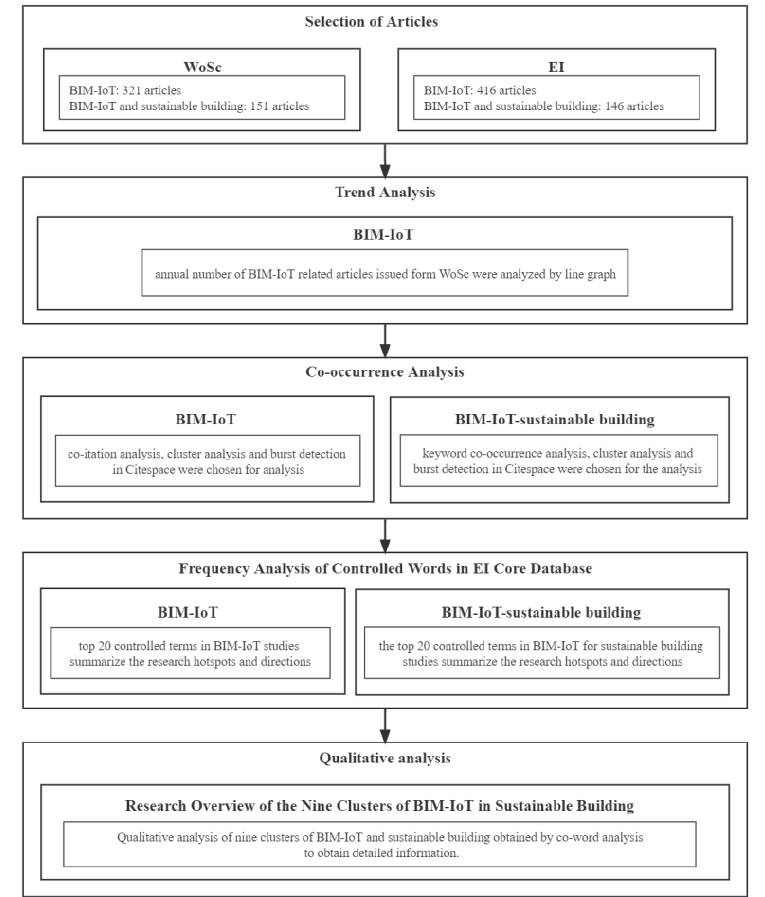
Figure 1. Research Methodology Flow Chart.